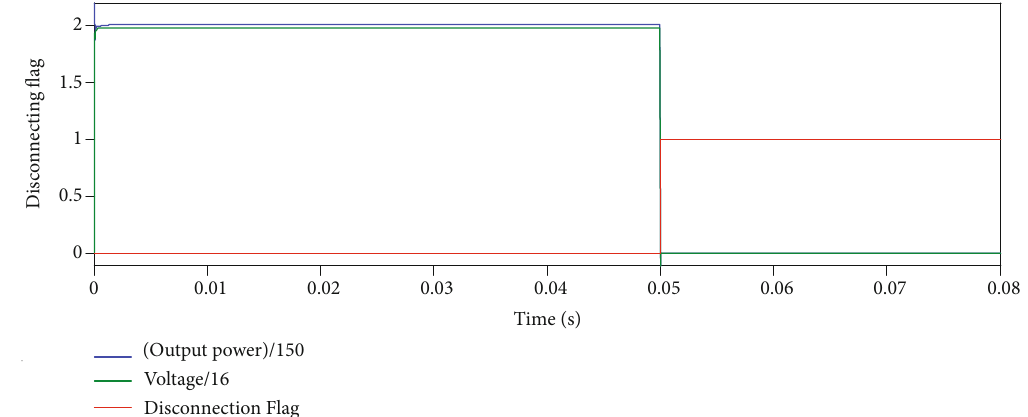
Figure 26: Panel 3 and the relevant bypass diode disconnection fault.